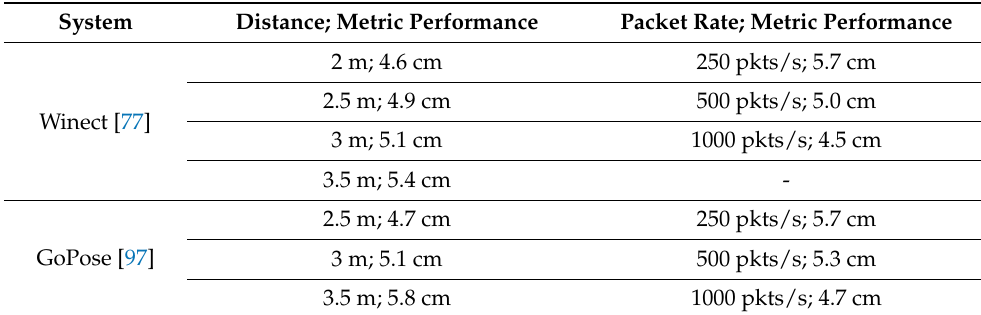
Table 8. Effects of Different Distance and Packet Rate on System